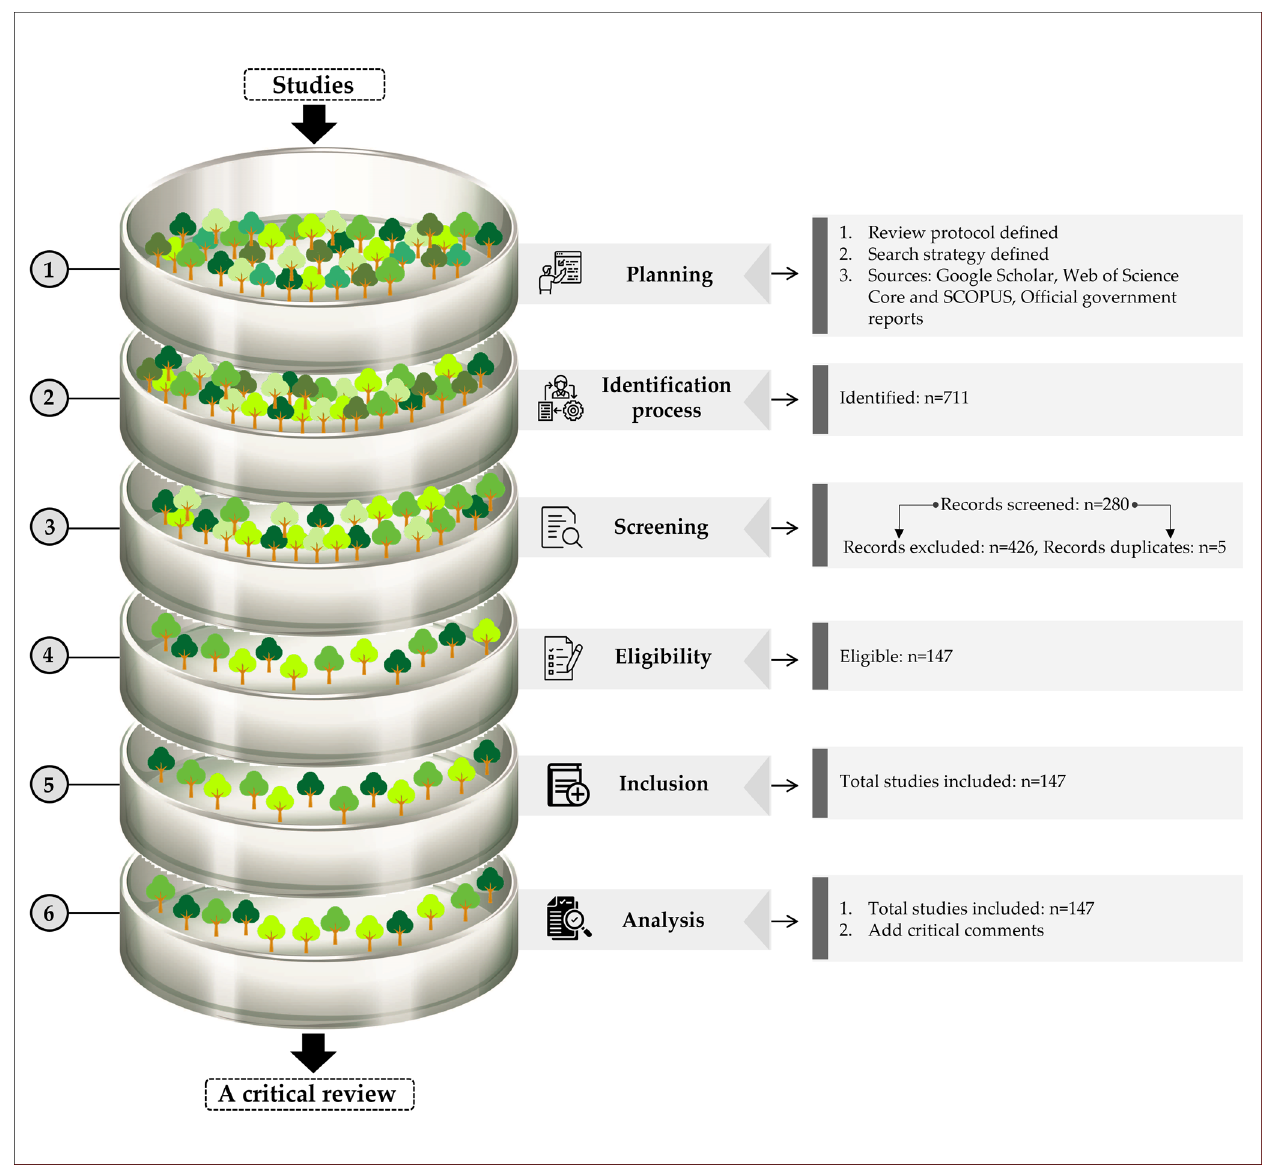
Figure 1. Steps used in the critical review.